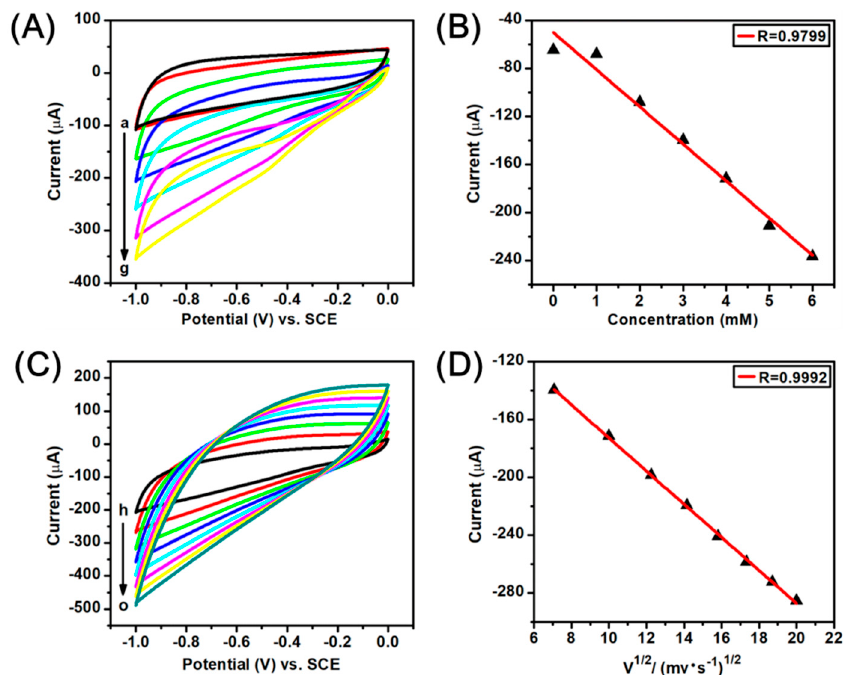
Figure 6. ( A ) CV curves of Ag-AuNPs/RGO modified GCE obtained in Ar-saturated 0.1 M PBS (pH 7.2) with different concentration H 2 O 2 (a–g: 0, 1, 2, 3, 4, 5 and 6 mM), scan rate: 50 mV·s − 1 ; ( B ) Linear fitting curve of the reduction peak current ( − 0.65 V) vs. the H 2 O 2 concentration; ( C ) CV curves of Ag-AuNPs/RGO modified GCE in Ar-saturated 0.1M PBS (pH 7.2) containing 3mM H 2 O 2 at different scan rates (h–o: 50, 100, 150, 200, 250, 300, 350, and 400 mV·s − 1 ); ( D ) the corresponding calibration plot of the reduction peak current ( − 0.65 V) vs. the square root of scan rate.